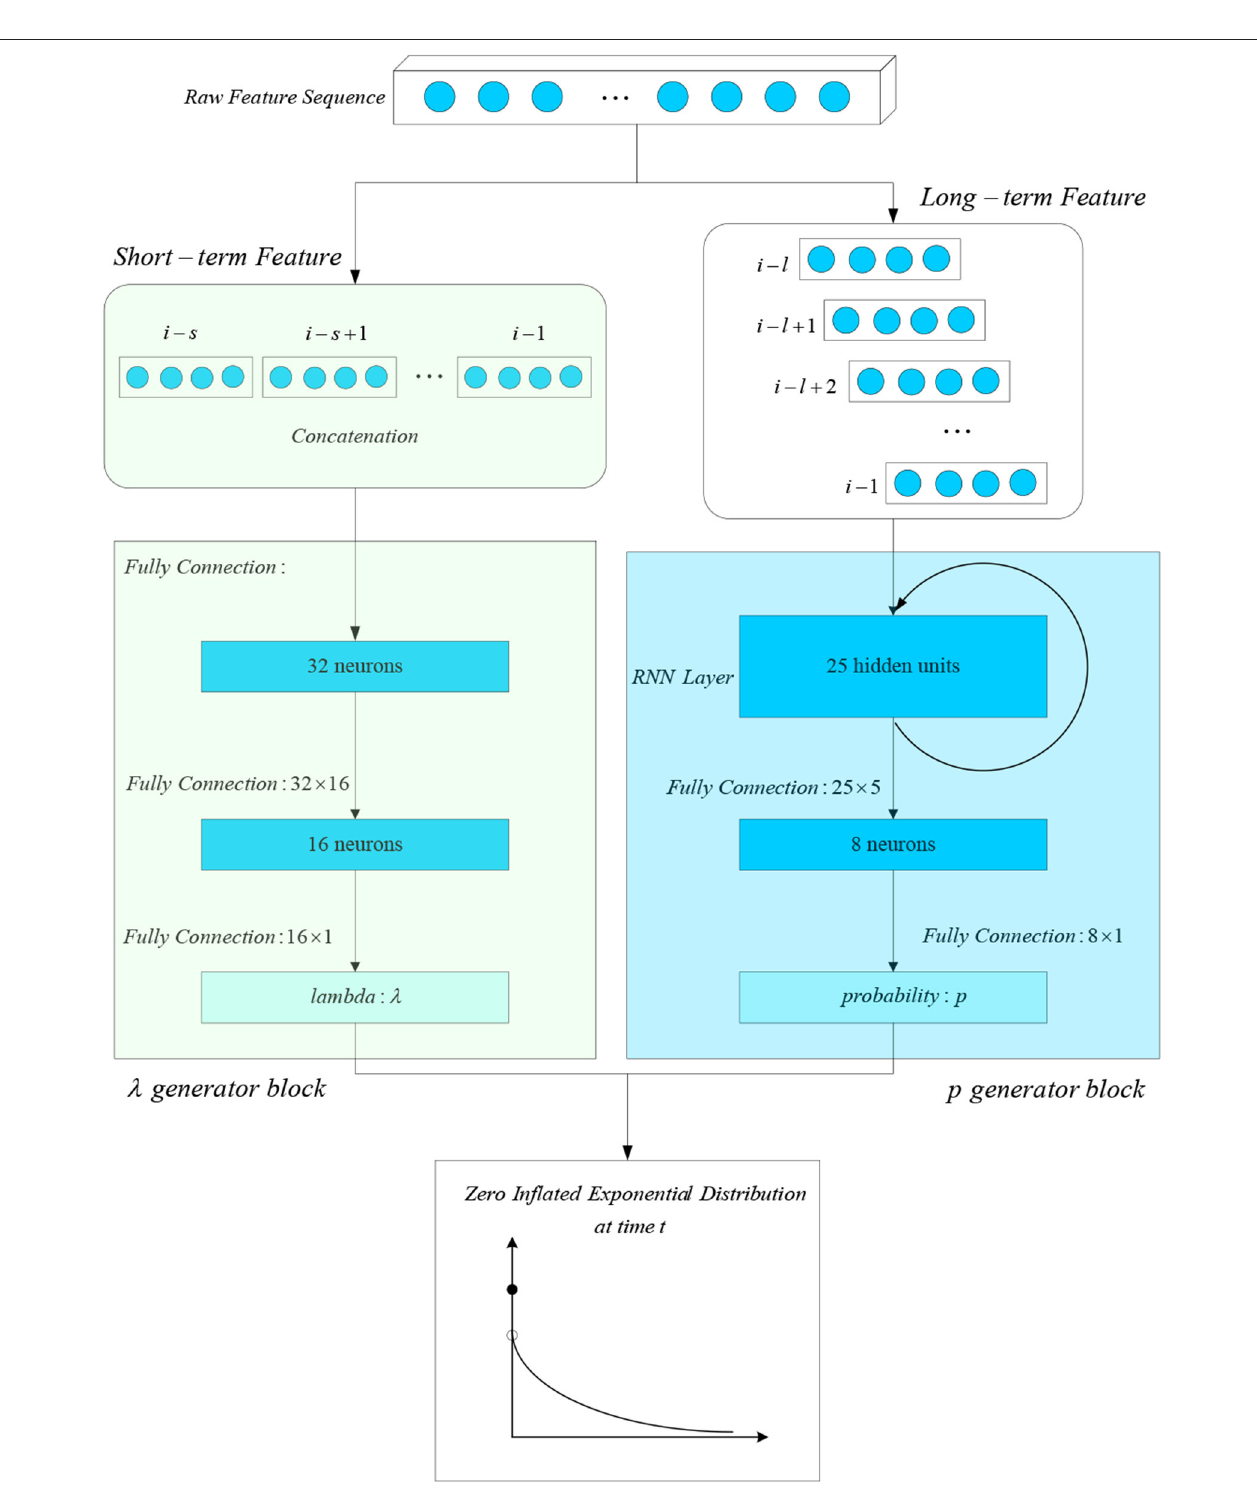
FIGURE 1 | Architecture of the DL-ZIACD